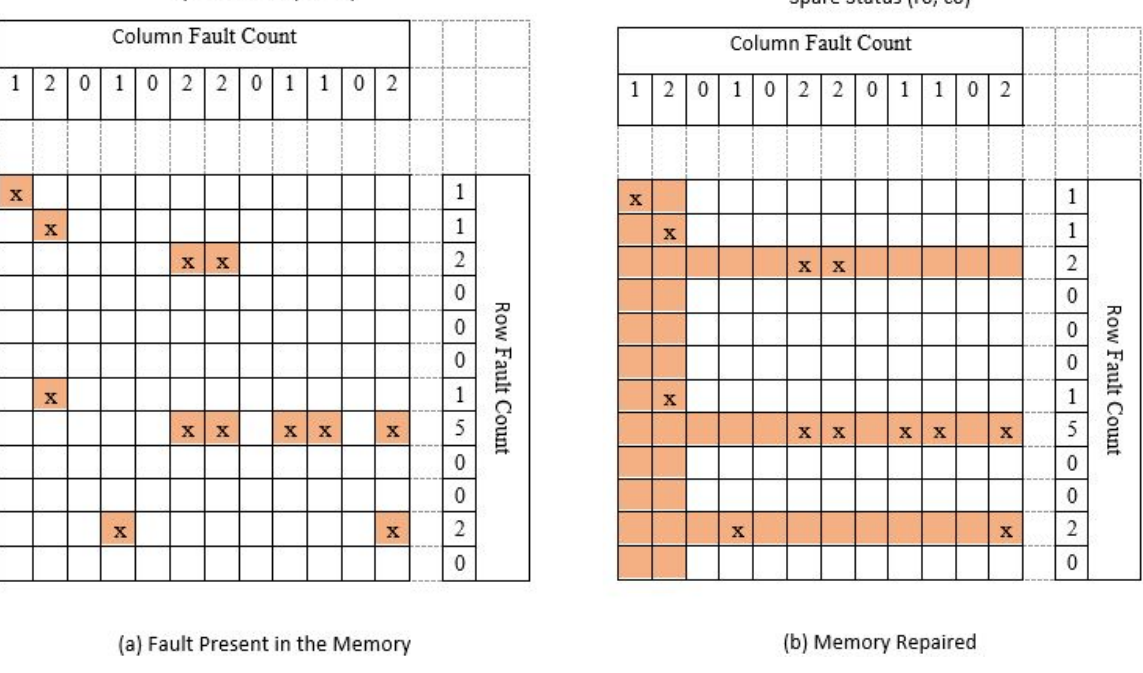
Figure 5. Memory with faults and repair process by the proposed BIRA scheme: ( a ) fault present in the memory under test; ( b ) memory repaired by the proposed method.